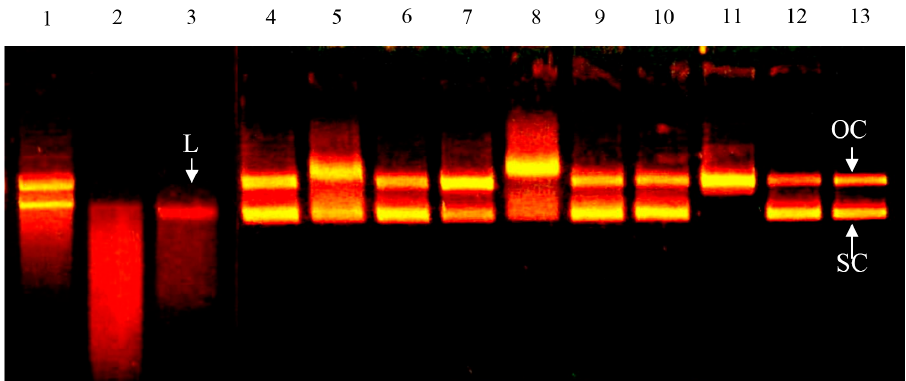
Figure 2. Effect of bovine colostrums protein on DNA single-strand cleavage induced by Fe 2+ and